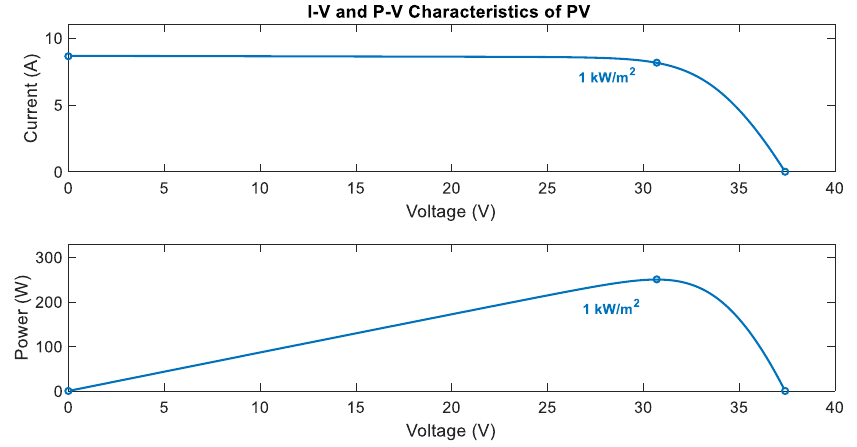
Figure 5. I-V and P-V characteristics of PV panel.